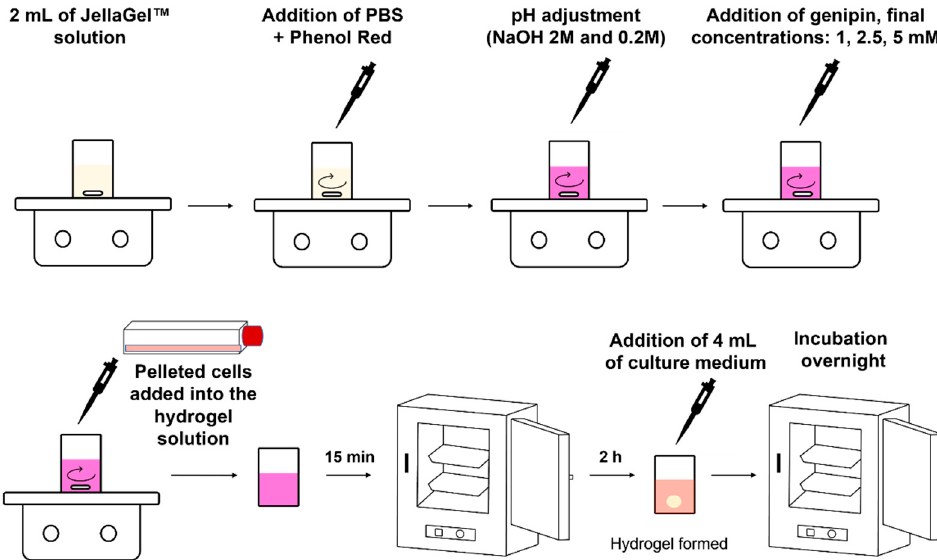
Figure 1. Graphical representation of the hydrogel preparation procedure: the different phases needed for preparing the hydrogels starting from JellaGel ™ solution and the key parameters for each step are depicted.